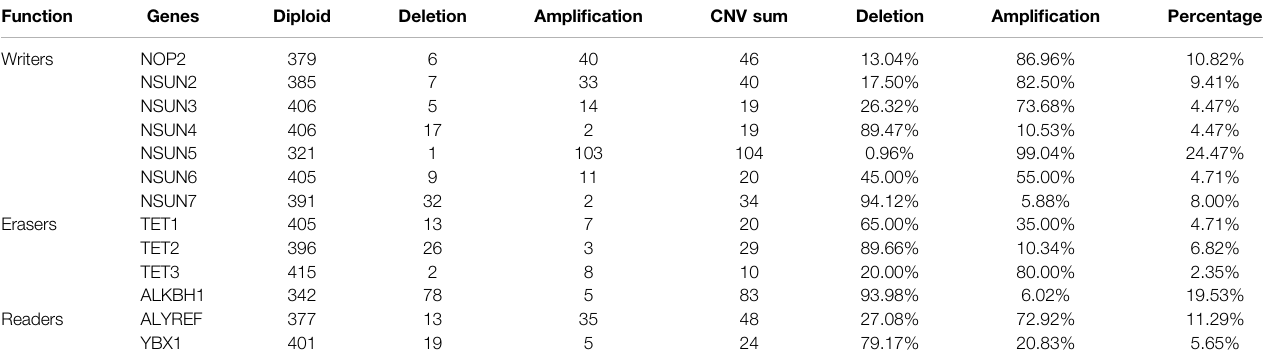
TABLE 2 | Copy number variants (CNV) of m5C related regulators in colon